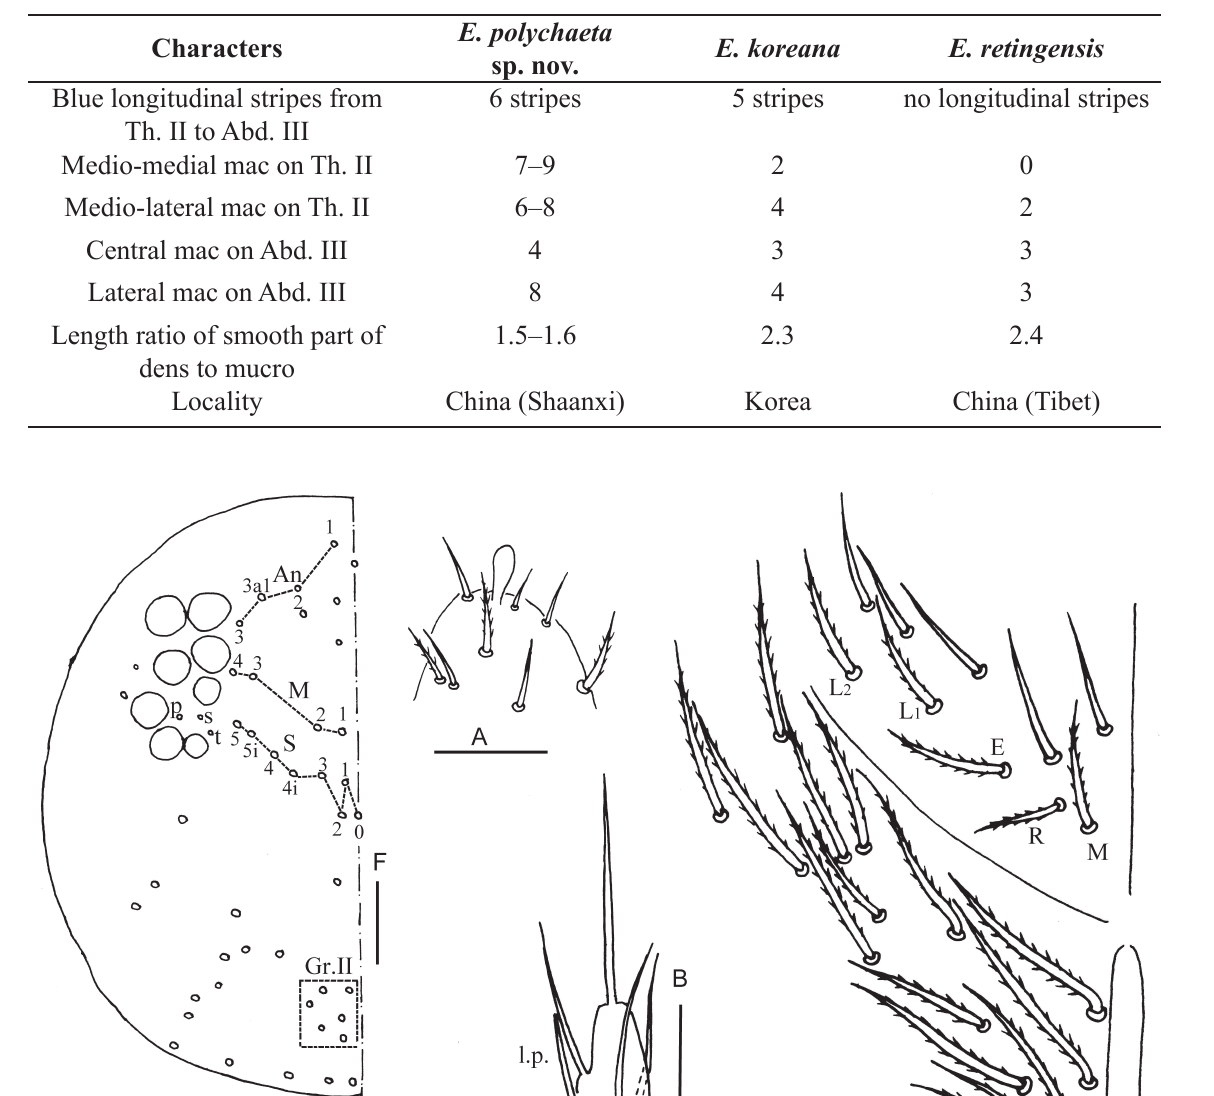
Table 2. Comparison among Entomobrya polychaeta sp. nov., E. koreana Yosii, 1965 and E. retingensis Baquero & Jordana, 2008 .